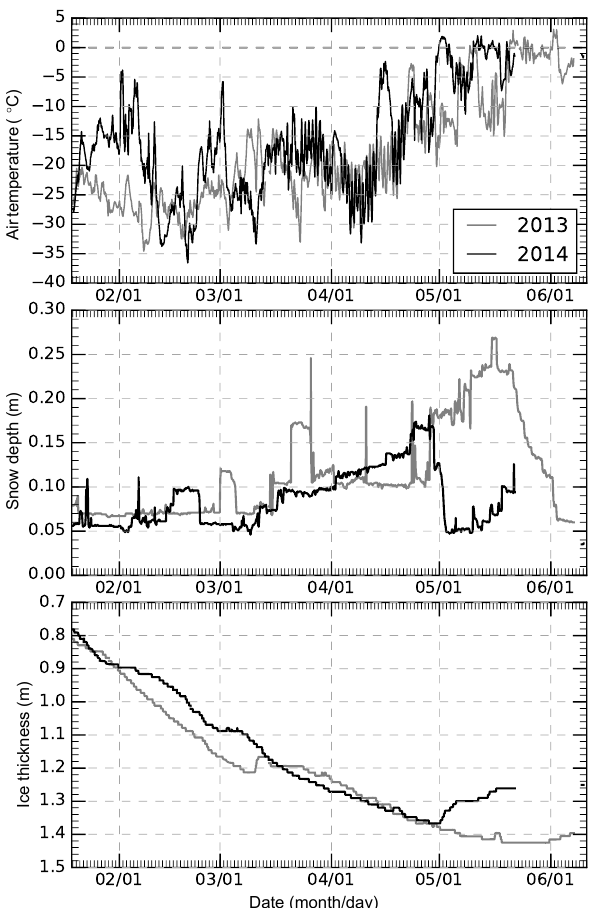
Figure 3. Air temperatures, snow depth, and ice thickness for 2013 and 2014 starting 18 January and ending 11 June. 2013: black solid line; 2014: gray solid